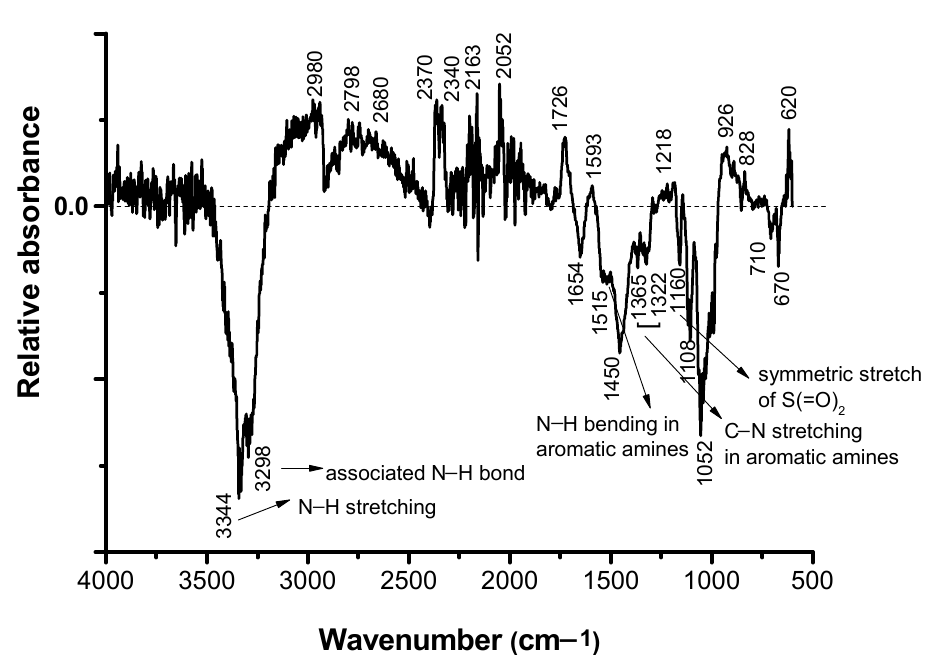
Figure 8. FTIR spectrum of the cotton fabric dyed with RB_204.